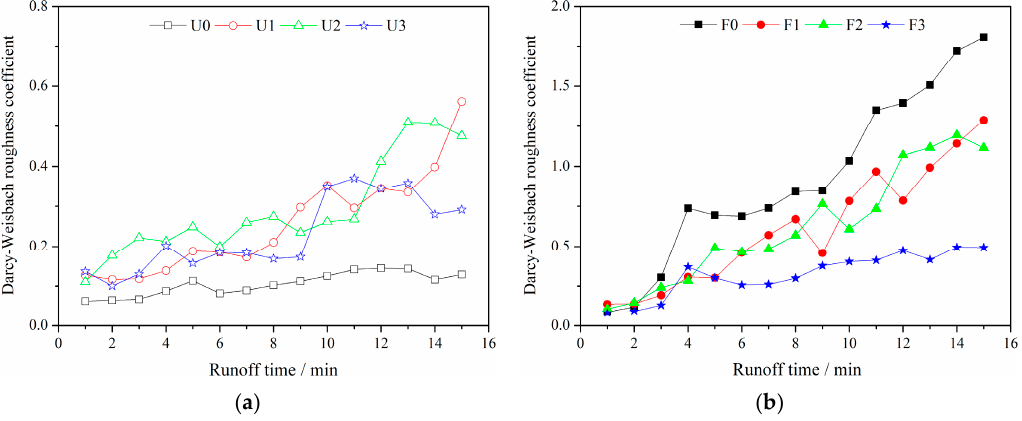
Figure 7. Variations in the Darcy-Weisbach roughness coefficient under different treatments over time. ( a ) Unfrozen slope, ( b ) frozen slope.